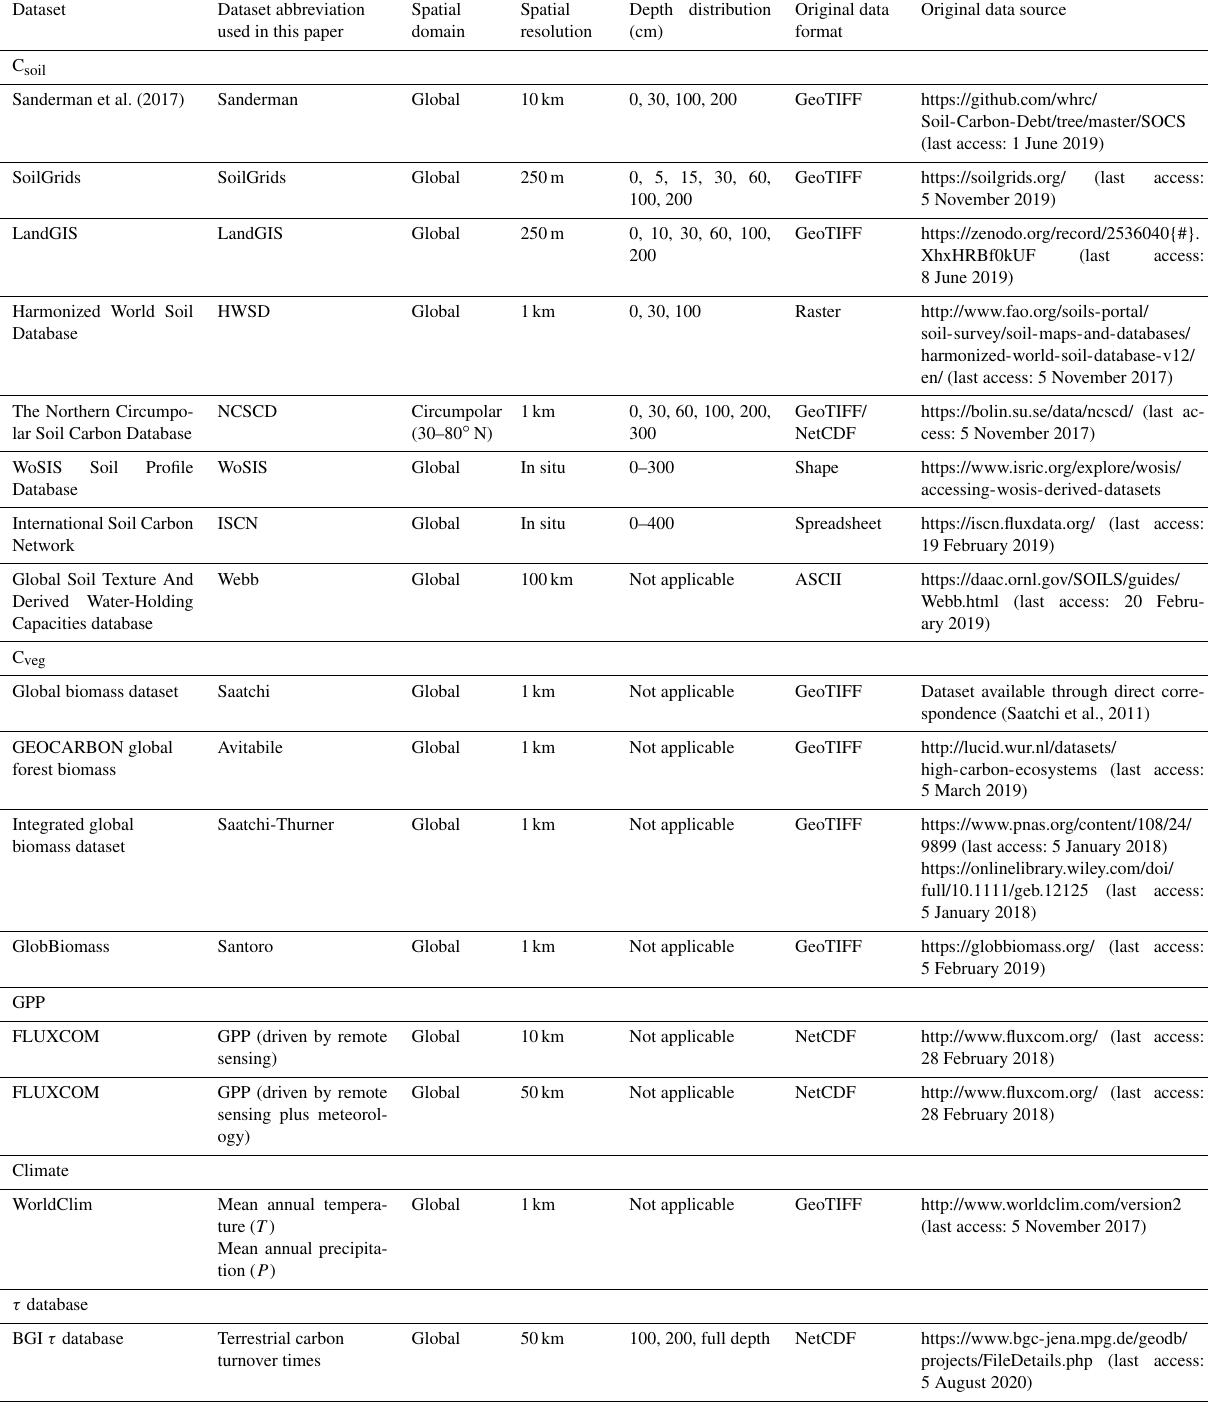
Table 1. Overview of the data used and produced in this study.